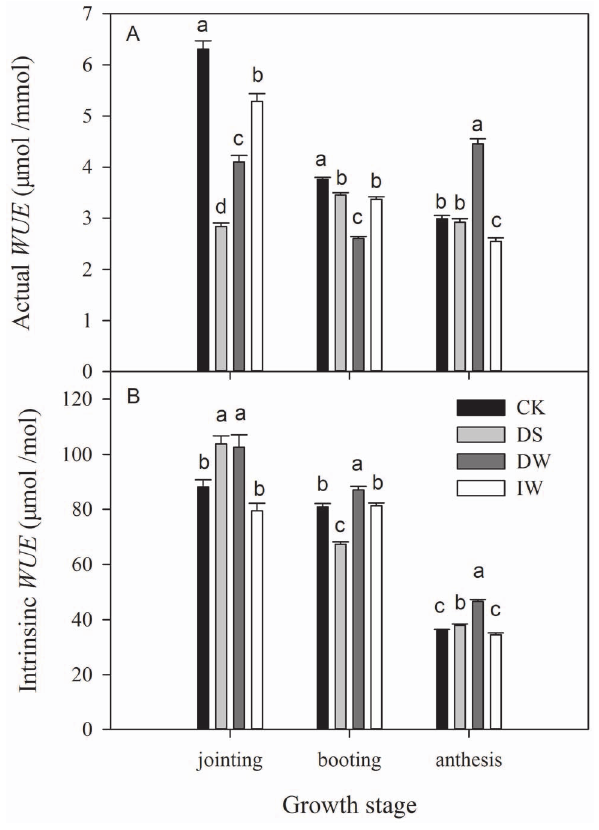
Figure 10. Seasonal changes in (A) actual water use efficiency ( WUE ) and (B) intrinsic WUE in winter wheat under four treatments (CK, DS, DW and IW), during growth stages. Significant differences ( P , 0.05) are indicated with different lower